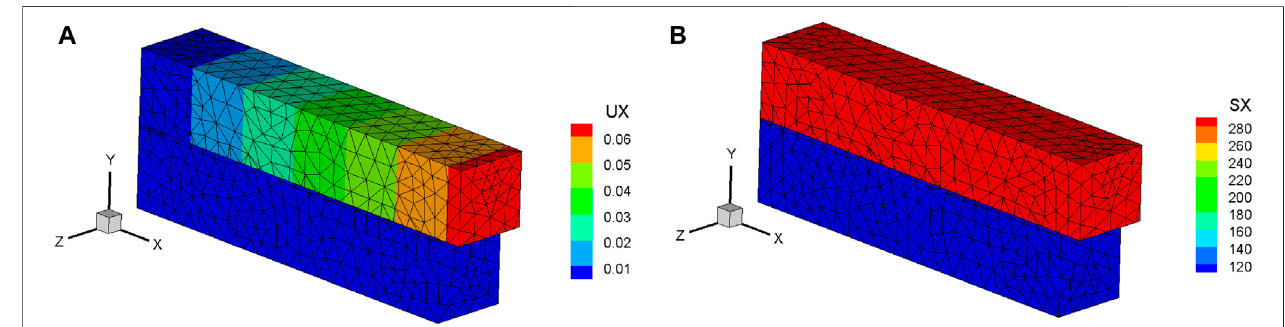
FIGURE18| Stressanddisplacementresultsusingmixedintegrationschemewithunstructuredmesh. (A) x -directiondisplacement(Unit:m); (B) x -directionstress (Unit: MPa).